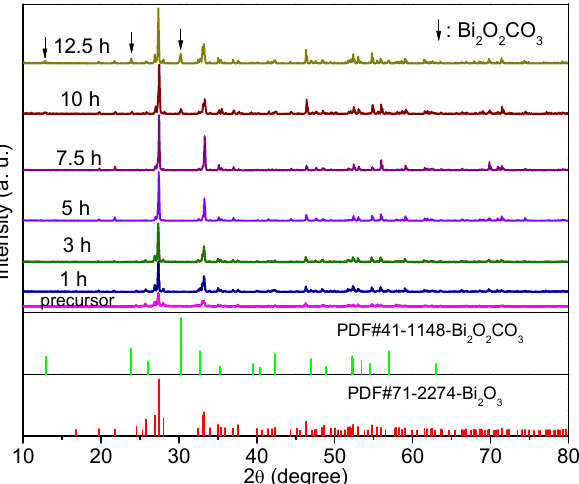
Figure 3. XRD patterns of the precursor and the samples obtained at 140 ◦ C for 1, 3, 5, 7.5, 10 h, and 12.5 h in the ethylenediamine–water mixture with a V en :V water ratio of 2:6. This is also supported by FT-IR spectra of the precursor and the products obtained after solvothermal treatment for 7.5 h and 10 h (Figure 4). For all the samples, the weak adsorptions at 1460, 1384, and 1315 cm −1 may be attributed to the carbonated species formed by the reactions between the surface hydroxyl groups and atmospheric CO 2 . The peaks at around 545, 505, and 430 cm −1 are due to the vibration of Bi-O bonds in BiO 6 octahedral units [24,25]. It is necessary to mention that only the product obtained after solvothermal treatment for 10 h shows an extra band at 850 cm −1 , which is ascribed to the CO 32− , indicating the formation of Bi 2 O 2 CO 3 at this stage [24,25].